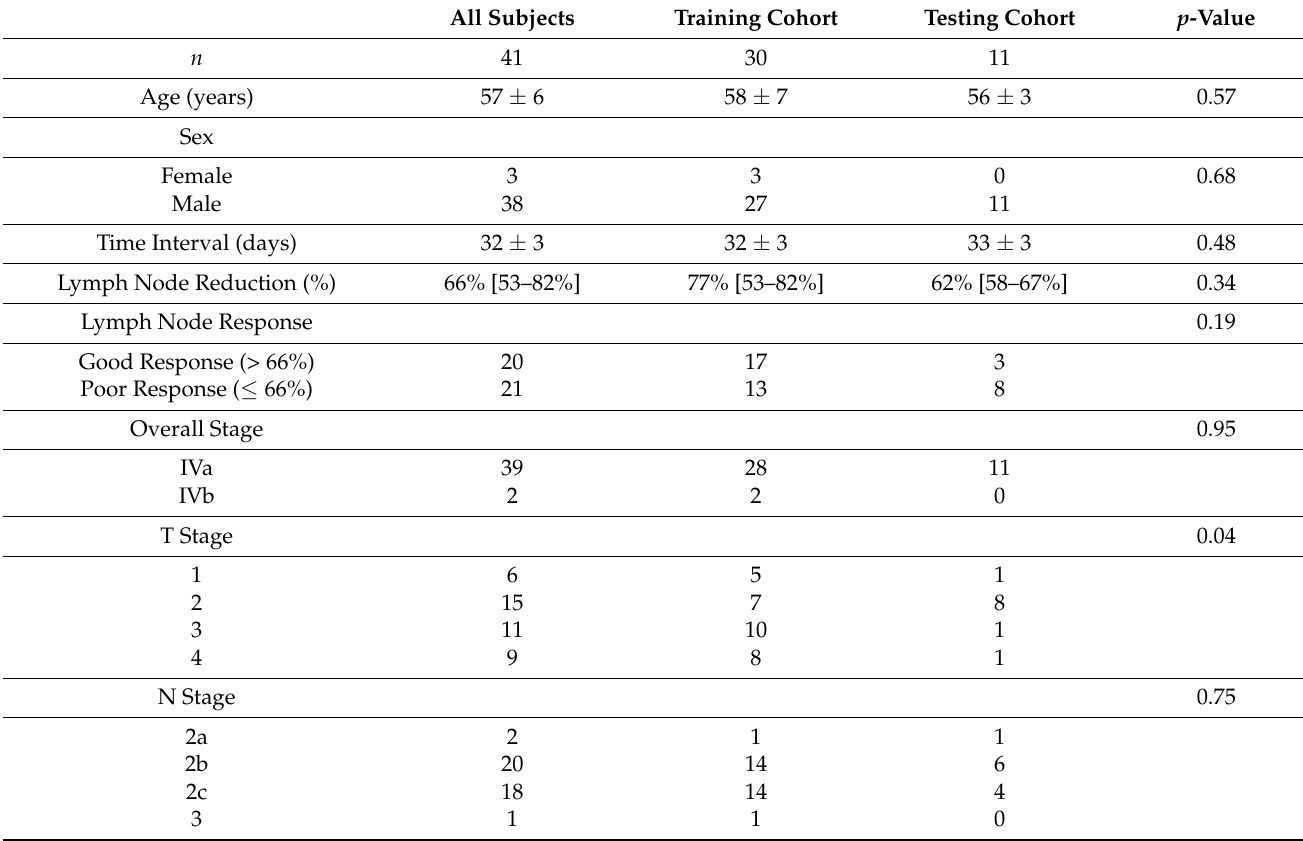
Table 1. Clinical characteristics of the patient